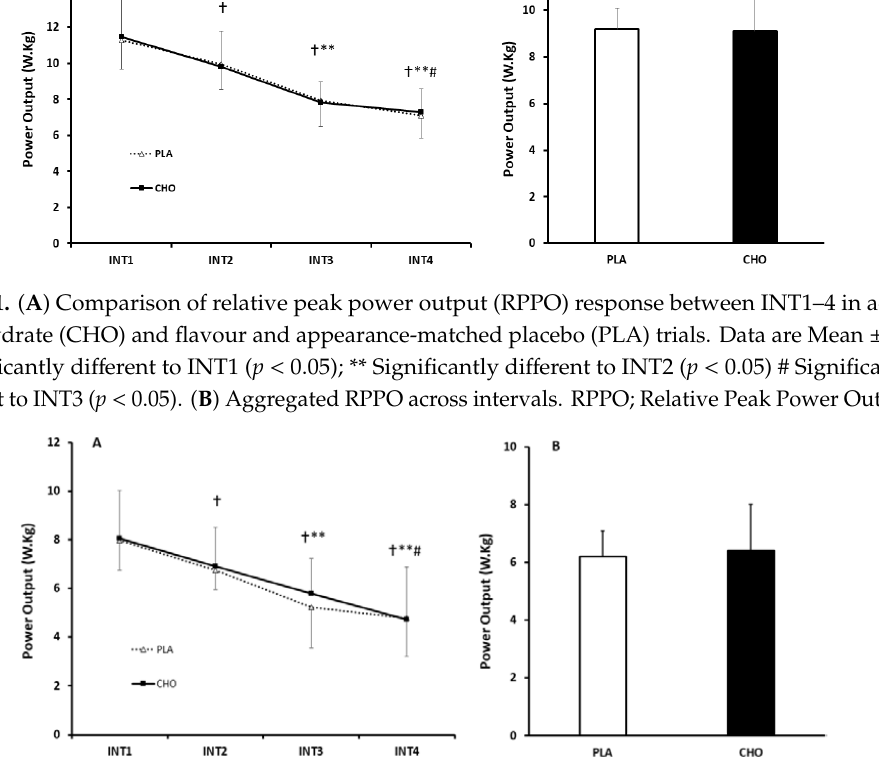
Figure 2. ( A ) Comparison of RMPO response between INT1–4 in CHO and PLA trials. Data are Mean ± SD. † Significantly di ff erent to INT1 ( p < 0.05); ** Significantly di ff erent to INT2 ( p < 0.05) # Significantly di ff erent to INT3 ( p < 0.05). ( B ) Aggregated RMPO across intervals. RMPO; Relative Mean Power